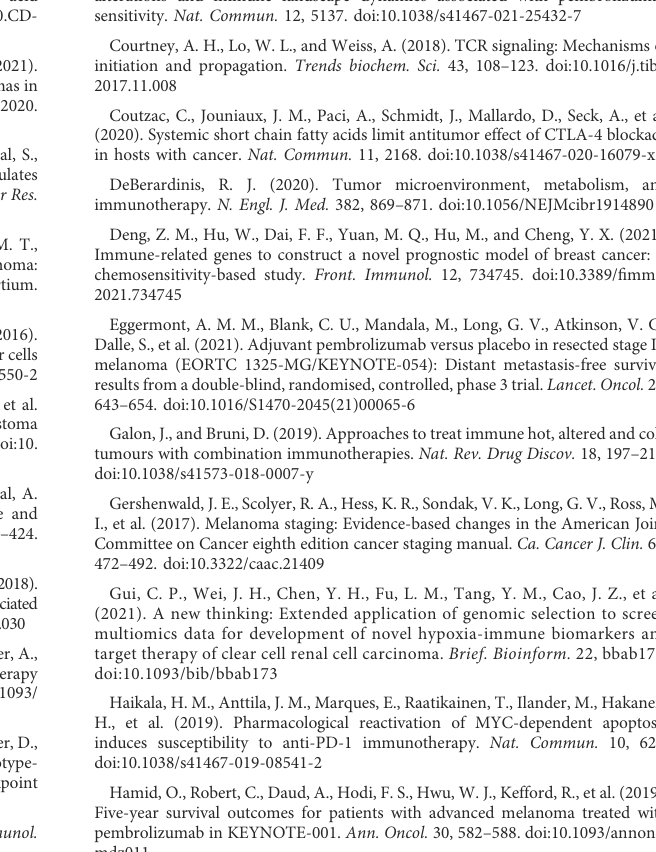
SUPPLEMENTARY FIGURE S1 NMF of the external validation cohort and GSEA of clusters in the TCGA cohort. (A,B) All the heatmaps and NMF rank surveys of the external validation cohort. (C) GSEA of cluster 2 CM in the TCGA cohort. (D) GSEA of cluster 1 CM in the TCGA cohort. SUPPLEMENTARY FIGURE S2 Prognosis value of the risk model. SUPPLEMENTARY FIGURE S3 Clinical analyses of risk group CM patients. (A) t-SNE, PCA, and 3D PCA of risk groups. (B) GSEA of the low-risk group. (C) Immune heatmap of risk groups. (D) Correlation between risk scores and immune in fi ltrates. (E) Comparisons of immune-related scores in risk groups. * p < 0.05, ** p < 0.01, and *** p < 0.001. A p value of < 0.05 was considered to indicate a statistically signi fi cant